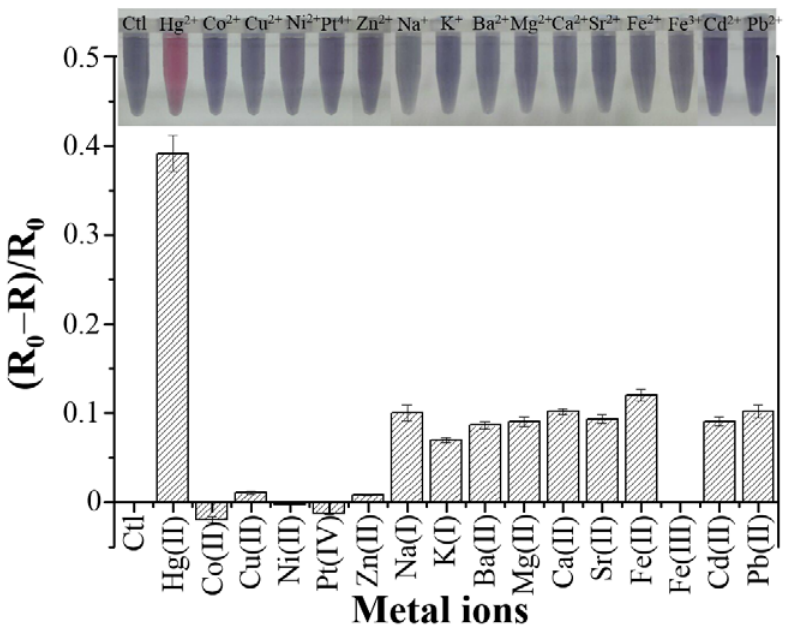
Figure 8. Selectivity of the H-AuNS probe in the presence of HCl/Au(III)/H 2 O 2 solution toward Hg(II) ions. The Hg(II) concentration was 1.0 µM, and the concentration of each of the other metal ions was 10 µM. Inset: photographs of the H-AuNS probe with different metal ions in the presence of HCl/Au(III)/H 2 O 2 solution. Error bars represent standard deviations from three repeated experiments. The sensitivity of the H-AuNS probe in the presence of the HCl/Au(III)/H 2 O 2 solution was studied at its optimum conditions after being equilibrated at 60 ◦ C for 10 min by lowering the Hg(II) concentration to a level where the color change of the AuNP solution was detectable with the naked